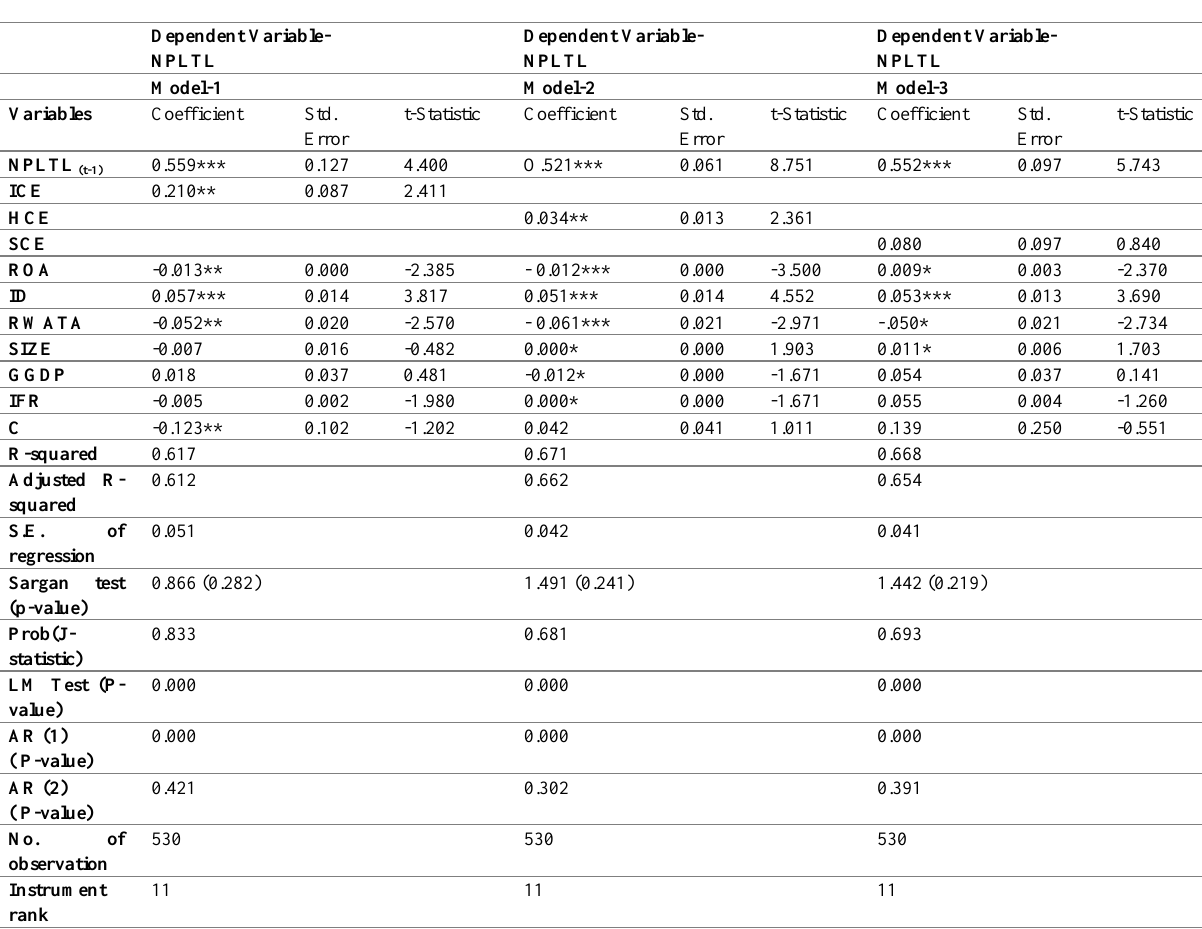
Table 4: Effects of IC Efficiency, HCE, SCE on credit